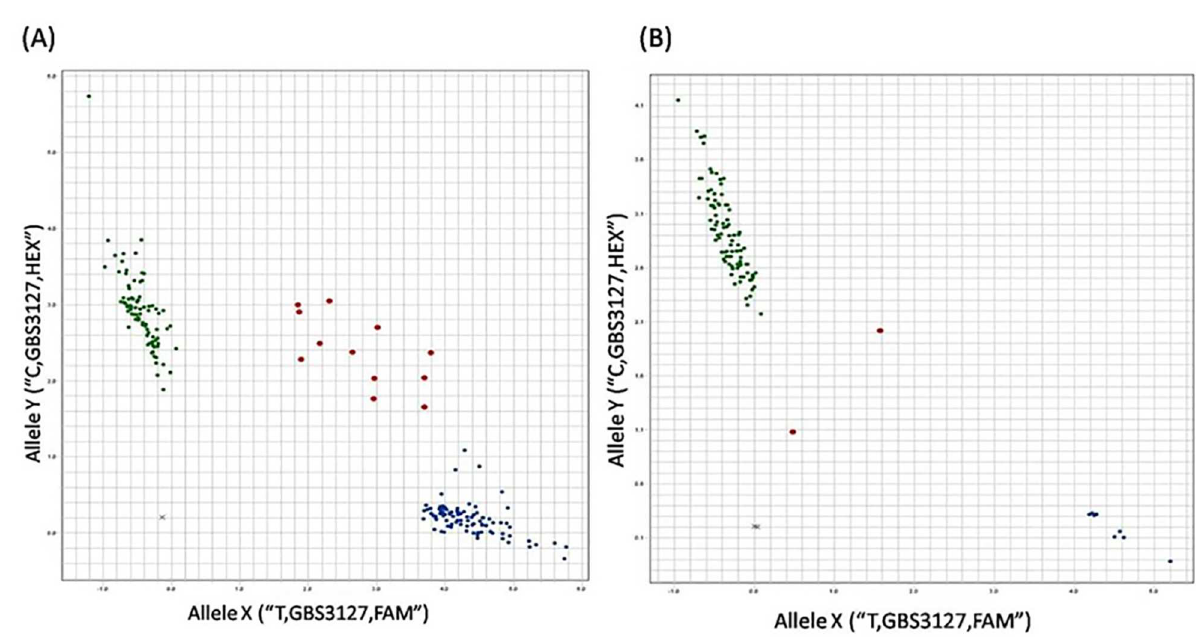
Fig 4. A KASP assay profile of SNP GBS3127 . A) SNP GBS3127 in 186 RILs of HYZ x Wheaton; B) SNP GBS3127 in 96 U.S. wheat associationmapping (AM). Blue dots represent T (resistance) allele, green dots represent C (susceptible) allele of GBS3127 , red dots refer to heterozygotes, and the black crosses are ddH 2 O